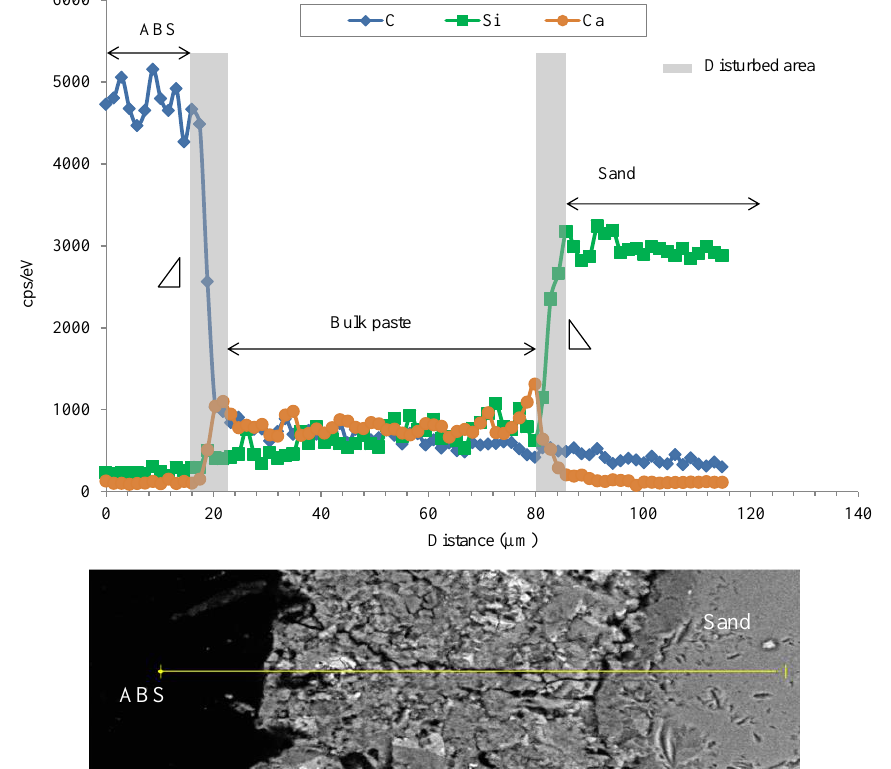
Figure 8. An example of Energy-Dispersive X-Ray analysis (EDX) of ABS/cement matrix and sand/cement matrix